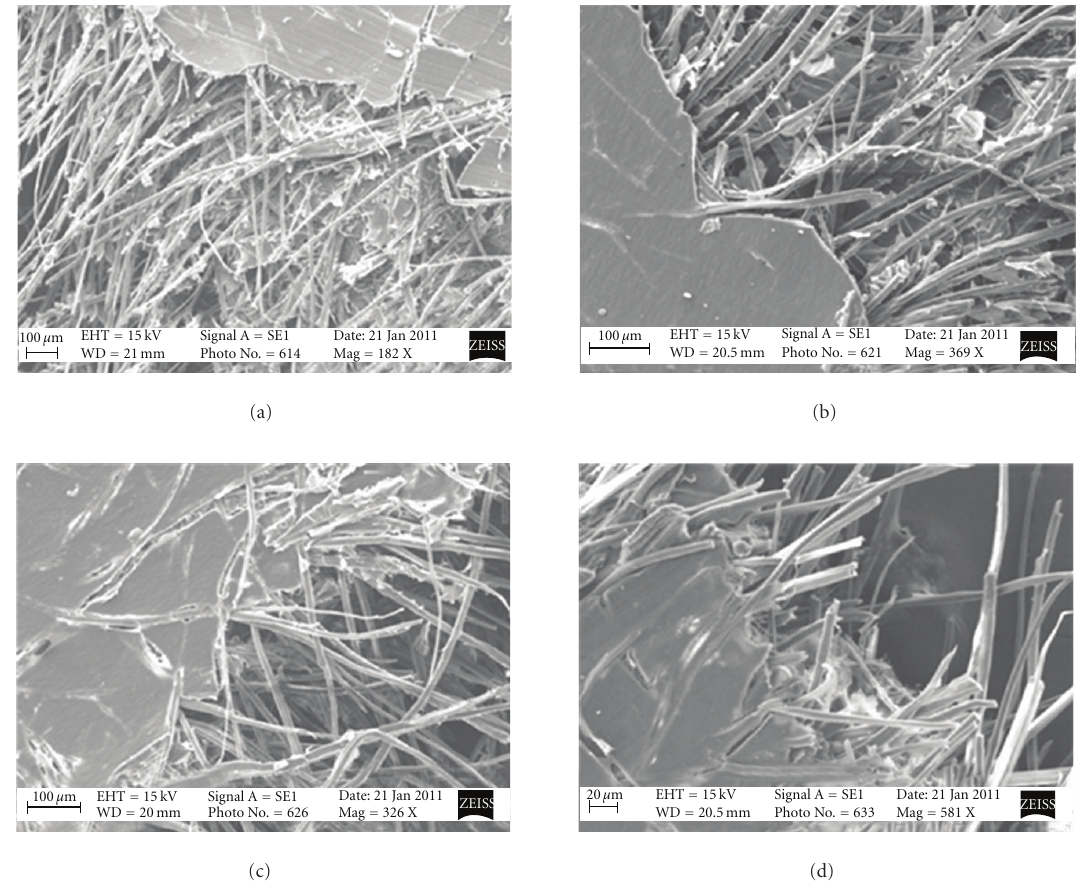
Figure 4: SEM images of the fracture surface of the PP composites reinforced with kenaf fibers digested at (a) 80 ◦ C, (b) 110 ◦ C, (c) 130 ◦ C, and (d) 160 ◦